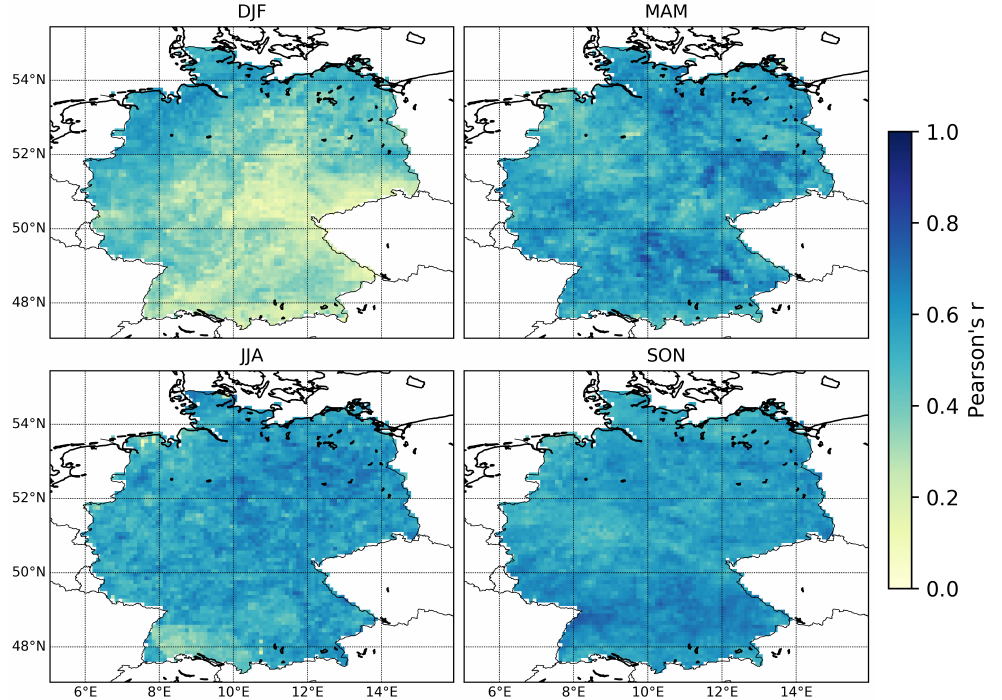
Figure 6. Pixel-by-pixel correlation of precipitation from GPM and RADOLAN datasets for seasons DJF, MAM, JJA, and